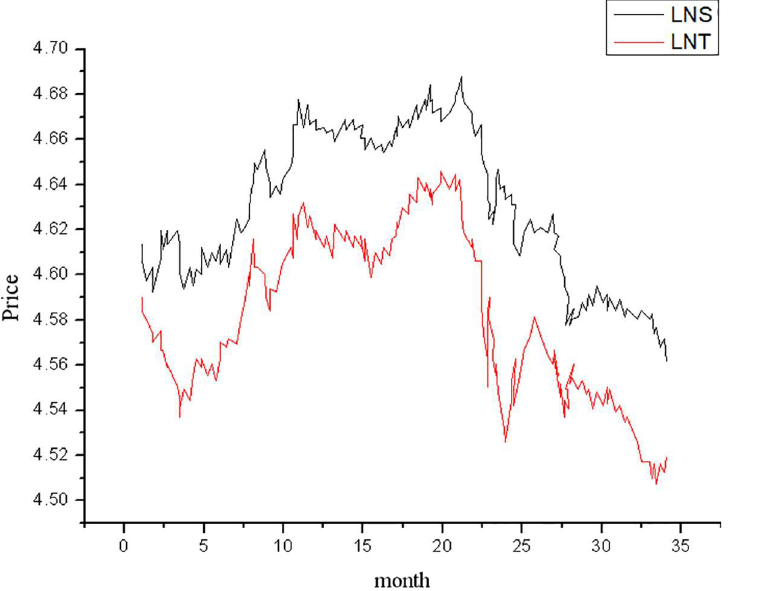
Fig 4. Trends of log prices of ten-year Treasury bill futures and spots in 2015–2017.